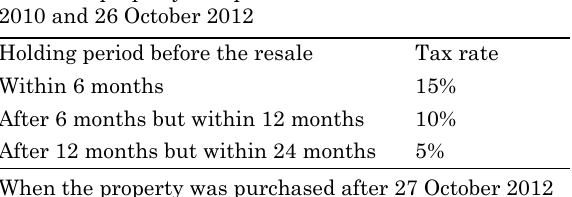
table 1. the rate of Special Stamp Duty in Hong Kong When the property was purchased between 20 november 2010 and 26 october 2012